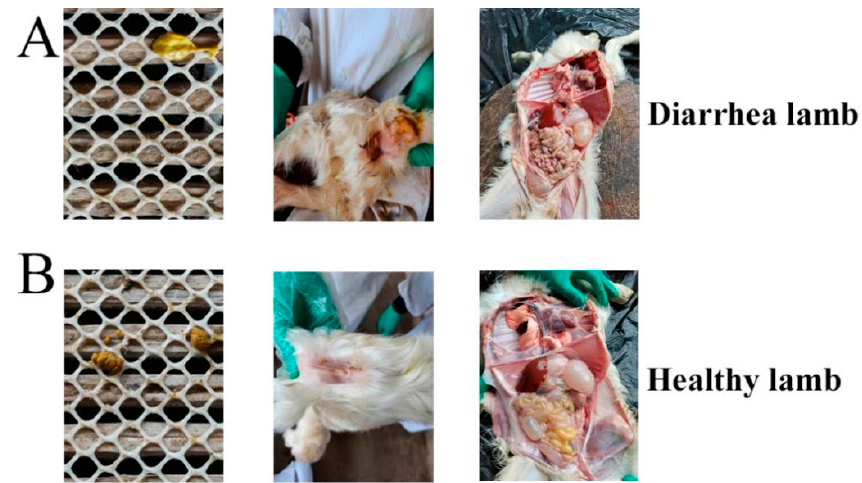
Figure 2. Histopathological detection of diarrheic lambs ( A ) and healthy lambs ( B ).